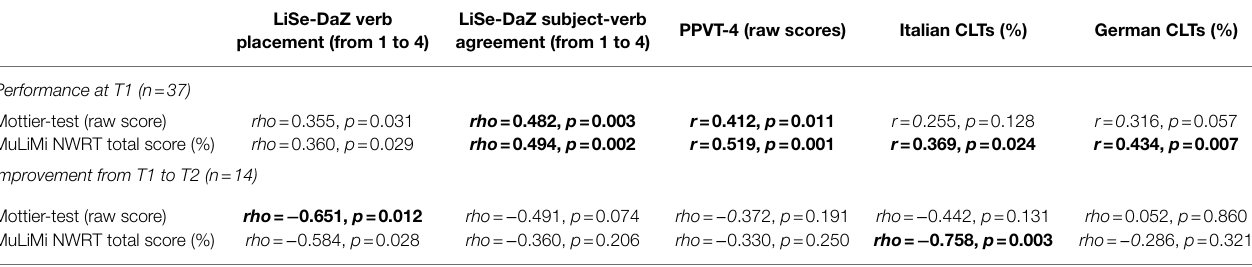
TABLE 4 | Correlations between children’s language test performance and the standardized (row 1) and the MuLiMi NWRT (row 2). LiSe-DaZ verb LiSe-DaZ subject-verb PPVT-4 (raw scores) Italian CLTs (%) German CLTs placement (from 1 to 4) agreement (from 1 to 4)